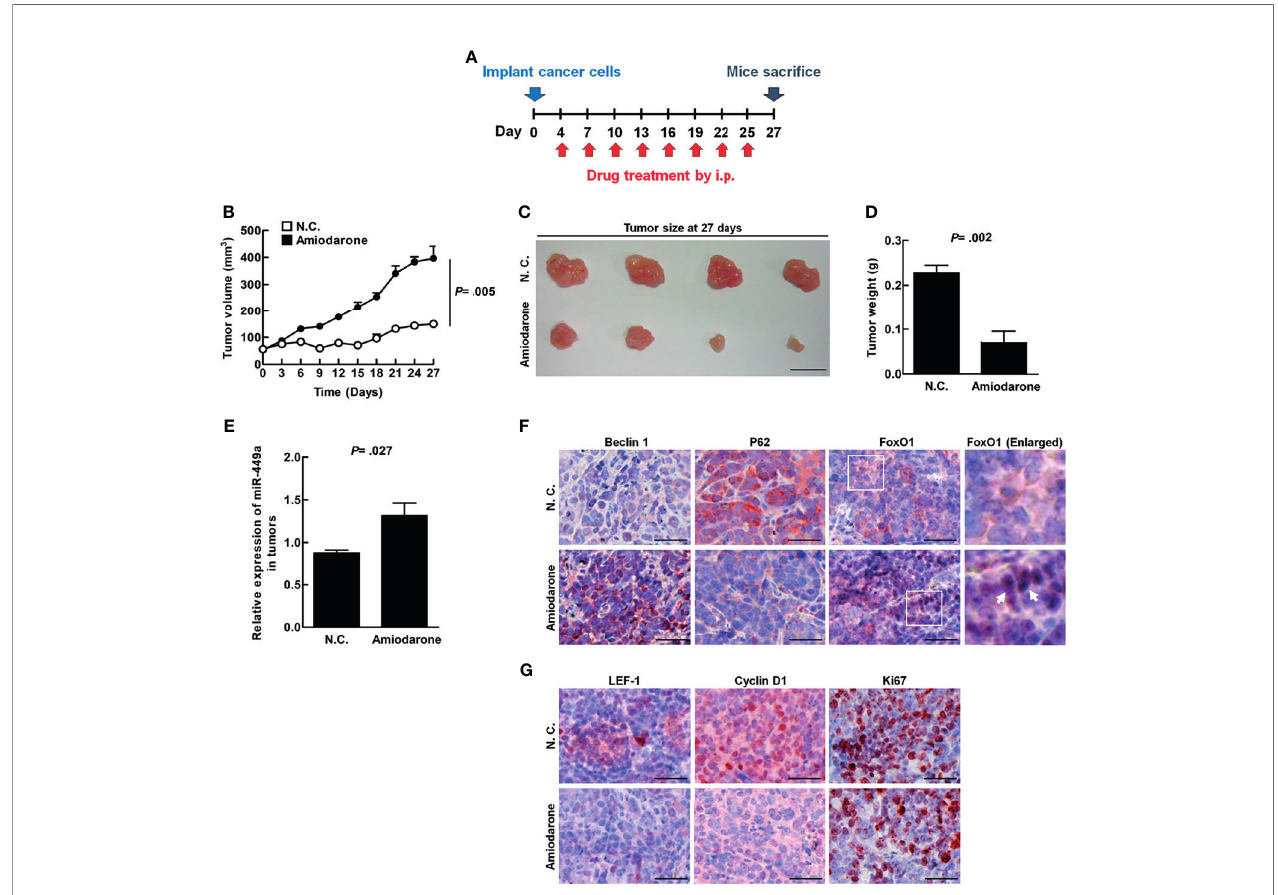
FIGURE 5 | Amiodarone-induced miR-449a speci fi cally blocks LEF-1 and cyclin D1 translation and suppresses CRC tumorigenesis in vivo. The four-week-old female NOD/SCID mice (n = 4) were s. c injected with SW480 cells (1x10 7 cells/100 m l). The mice were then injected intraperitoneally with 30 mg/kg amiodarone after four days ’ inoculation every 3 days for 27 days. (A) A schematic design of cancer cell inoculation and amiodarone injection in the animal experiment. (B) The tumor volume measured at 3-day intervals until day 27. (C) After mice were sacri fi ced, the tumors were collected and photographed. (D) Tumor weights were measured. (E) The expression of miR- 449a in the tumors was determined by real-time PCR. (F) The protein levels (red color) of Beclin 1, p62, and FoxO1 in the tumors with or without amiodarone treatment was determined by speci fi c antibodies using IHC staining. The arrow points the FoxO1 staining in the nucleus. (G) The levels of LEF-1, cyclin D1, and Ki67 in the tumors with or without amiodarone treatment were determined by IHC staining. The p values were determined by Student ’ s t -test